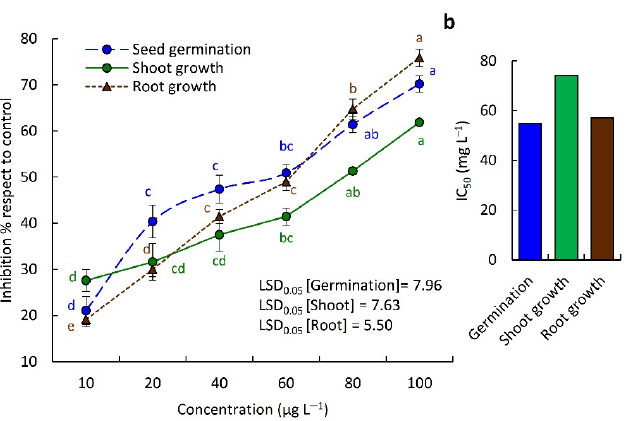
Figure 4. Allelopathic activity of the EO from the above-ground parts of Cleome amblyocarpa on the germination, root and shoot growth of Dactyloctenium aegyptium . ( a ) Various concentration and ( b ) IC 50 . Different letters within each line mean values significantly different at p < 0.05 (Tukey’s HSD test). To the best of our knowledge, the allelopathic activity of the EO from C. amblyocarpa has not been studied yet. However, the aqueous, hexane, chloroform, and methanol ex- tracts from C. amblyocarpa have been reported to inhibit lettuce germination and growth [45]. At a concentration of 6 g L − 1 , ethyl acetate showed a complete inhibition of lettuce growth, whereas Peganum harmala , Raphanus sativus , and Silybum marianum were more re- sistant. Additionally, Ladhari et al. [46] identified some terpenoids and flavonoids from C. amblyocarpa , where dammarane-type triterpenes showed strong allelopathic activity, and flavonoid compounds exhibited <50% inhibition of the targeted species. In our results, the allelopathic activity of C. amblyocarpa EO could be attributed to the activity of a single or combination of the major identified compounds. Caryophyllene ox- ide is reportedly a major compound of the EOs with substantial allelopathic activity such as C. plicata [34], H. curassavicum [33], Acroptilon repens [47], Teucrium arduini , T. montbretii [48], and Nepeta curviflora [49]. On the other hand, the EO from Launaea mucronata and L. nudicaulis showed the presence of hexahydrofarnesyl acetone as a major compound, where it revealed significant allelopathic activity against the weed: Portulaca oleracea [30].